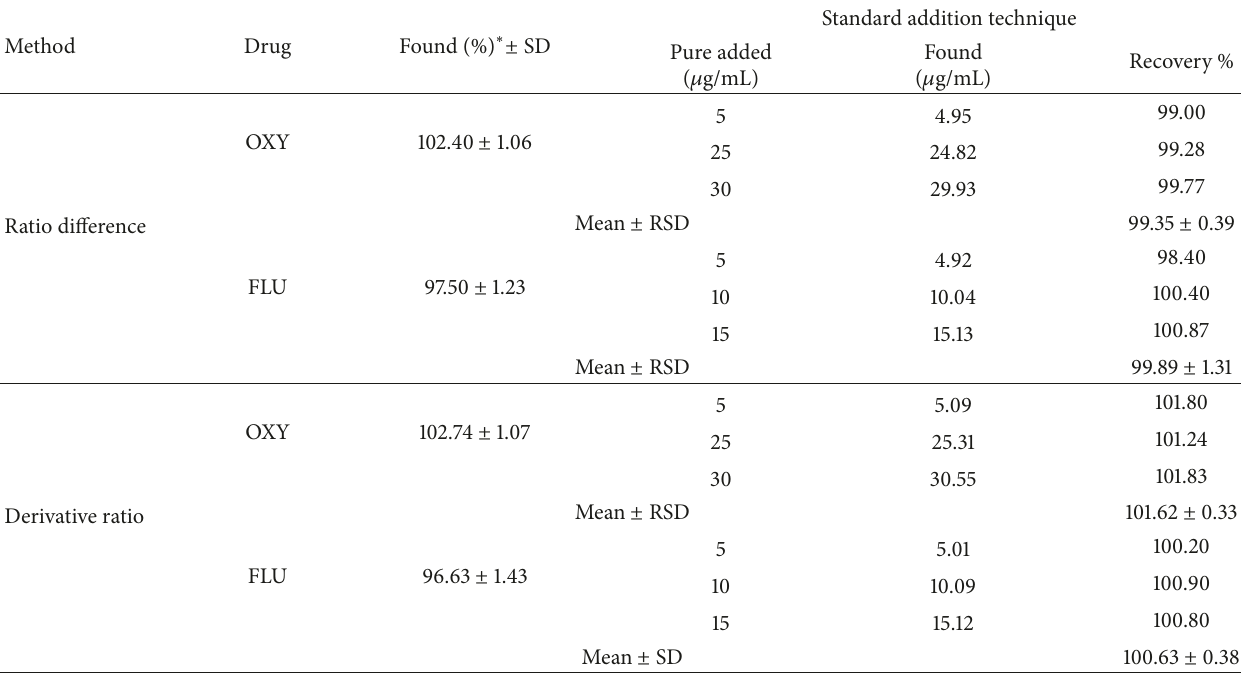
Table 4: Determination of Oxytetracycline HCl and Flunixin Meglumine in FLOXON by the proposed ratio difference and first derivative of ratio spectra spectrophotometric methods and application of standard addition